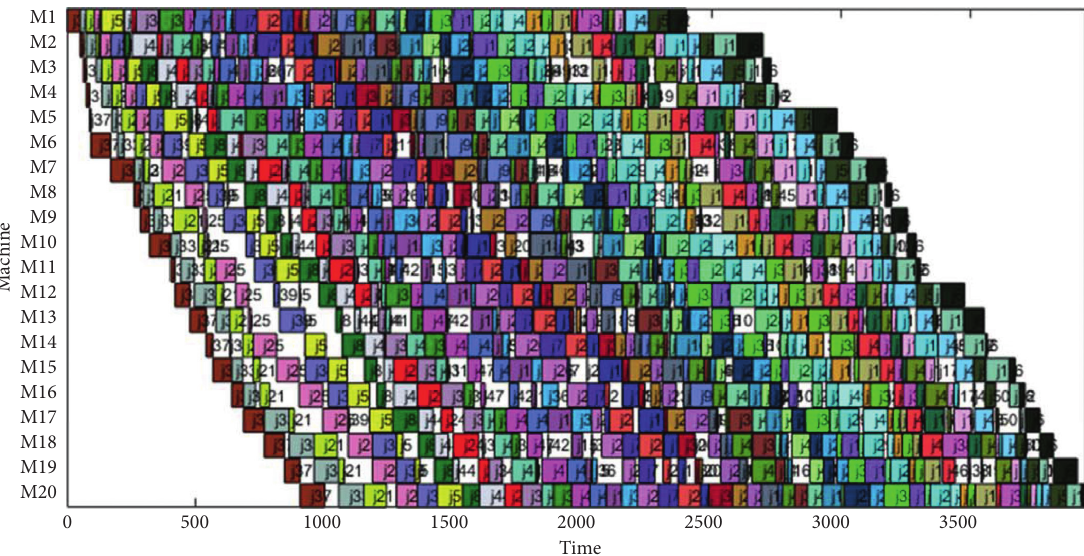
Figure 10: Gantt chart of the solution with GSFLA (workpiece: 50, machine: 20, makespan: 3948.57).